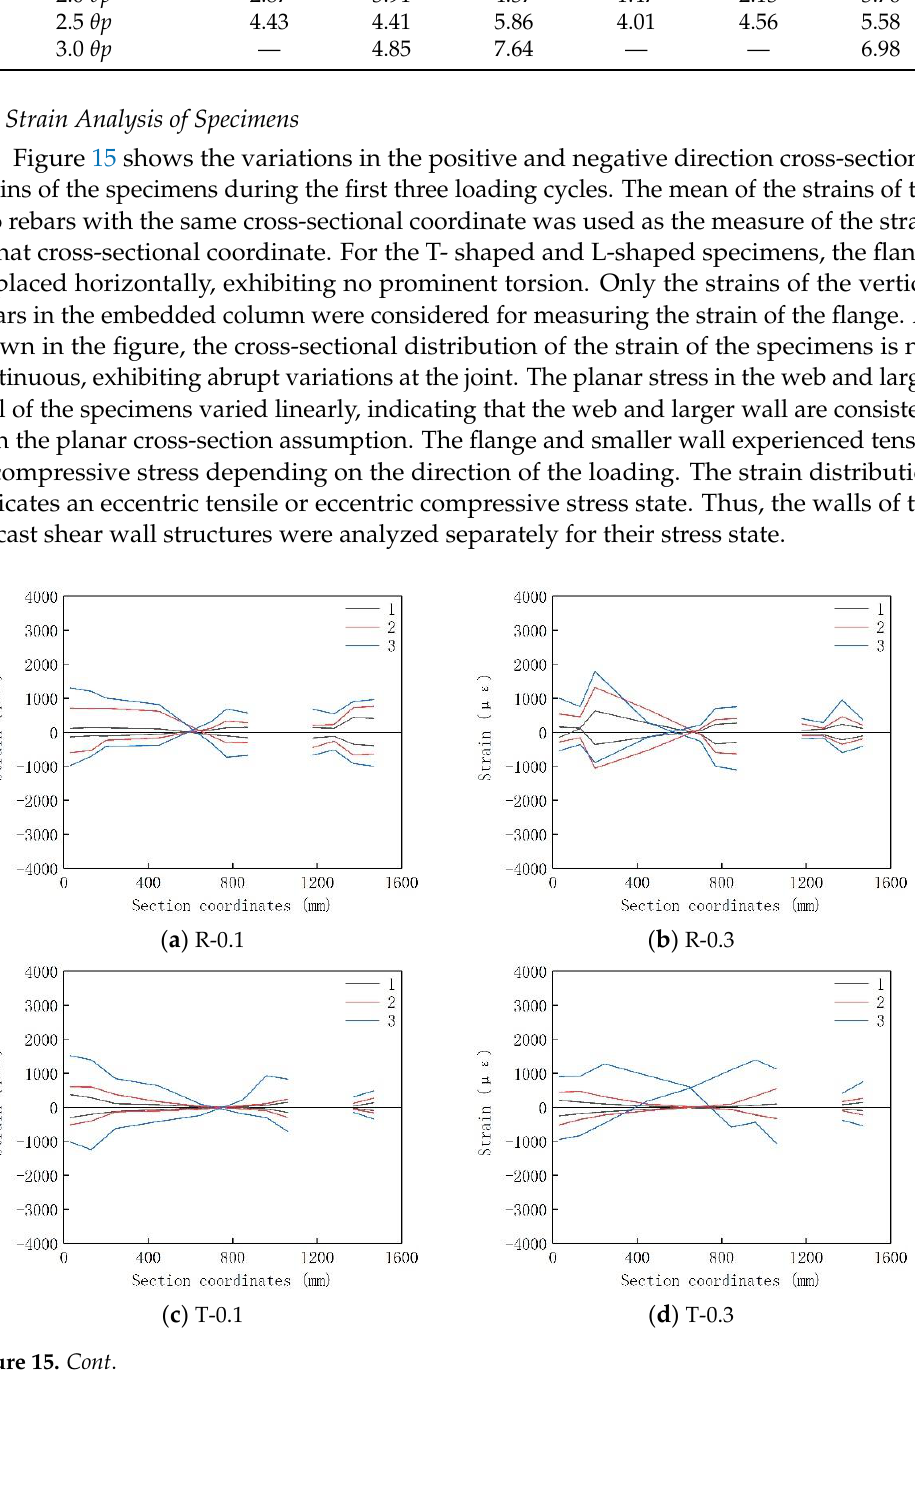
( f ) L-0.3 Figure 15. Strain of section. 6. Mechanical Model for Calculation of Bearing Capacity 6.1. Calculation Model Based on references [23 – 28] and the test results, when a yield mechanism formed in the specimens, a plastic hinge formed in the bottom part of the walls, and the dampers yielded. Thus, the overturning moment on the bottom cross-section of the shear walls can be considered as their overall ultimate flexural bearing capacity. Figure 16 shows a model for calculating the ultimate flexural bearing capacity of specimens.